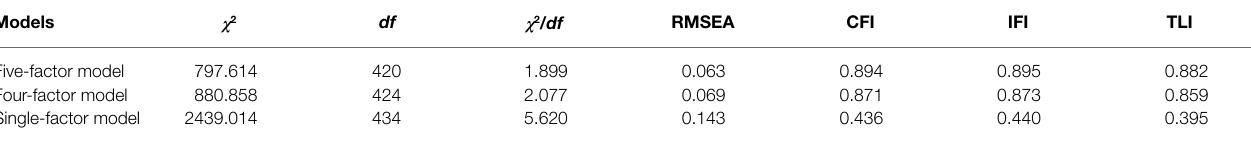
TABLE 1 | Comparison of measurement models.